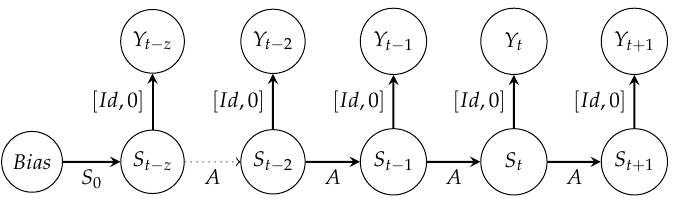
Figure 2. System Transitions at Neuron Level [35].